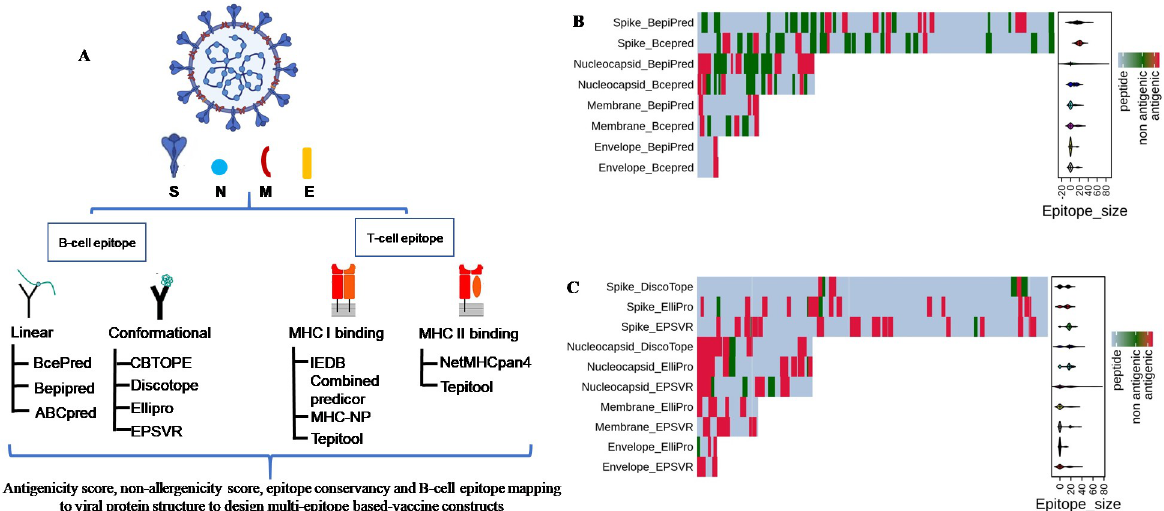
Fig 1. (a) Schematic representation of the in-silico workflow for the prediction of potential B- and T-cell epitopes of structural proteins (spike [S], envelope [E], membrane [M], and nucleocapsid [N] of SARS-CoV-2 and SARS-CoV. Summary of SARS-CoV-2-derived B-cell epitopes. Heat map showing the distribution of (b) linear (continuous) and (c) conformational (discontinuous) B-cell epitopes across the protein sequences of spike (1273 aa), nucleocapsid (419 aa), membrane (222 aa), and envelope (75 aa) proteins of SARS-CoV-2. Red represents the antigenic epitopes predicted using the methods described in Fig